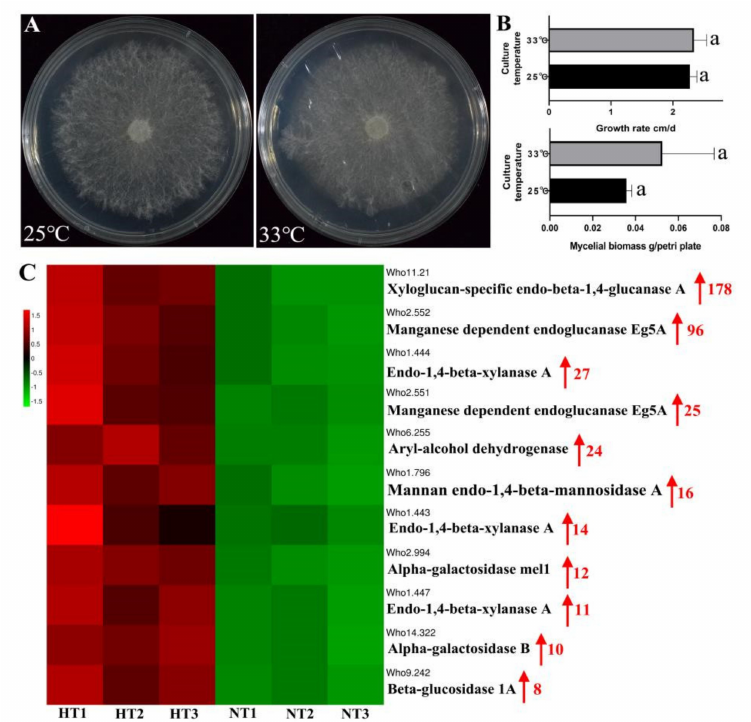
Figure 8. Transcriptome sequencing samples, biological characters, and differential gene expression. ( A ) Colony morphology of CGMCC 5.545 cultured under 25 ◦ C and 33 ◦ C; ( B ) Growth rates and mycelial biomass of CGMCC 5.545 cultured under 25 ◦ C and 33 ◦ C; ( C ) Differential express genes of significantly up-regulated genes. Note: NT presents mycelia cultured under normal temperature, 25 ◦ C, and HT presents mycelia cultured under highest tolerance temperature, 33 ◦ C. The a in subfigure B indicate the significant difference at p = 0.05 by Duncan’s multiple range tests. Red arrow in subfigure C present up-regulation expression and the number indicated upregulated